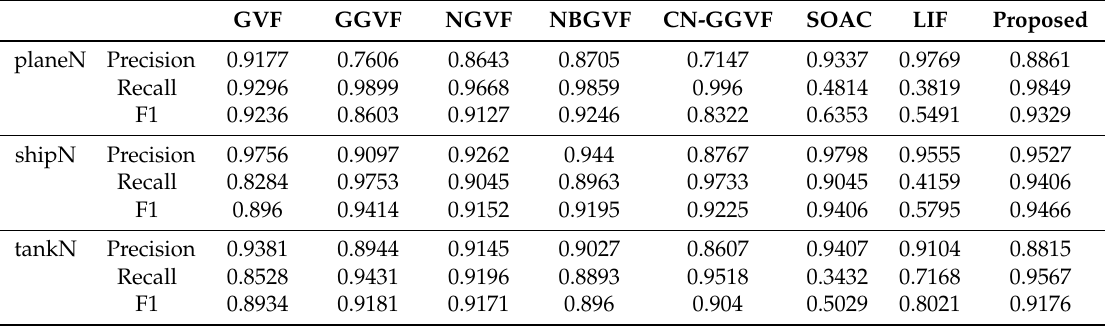
Table 3. The comparison of Quantitative evaluation results on infrared images corrupted with multiplicative noise.